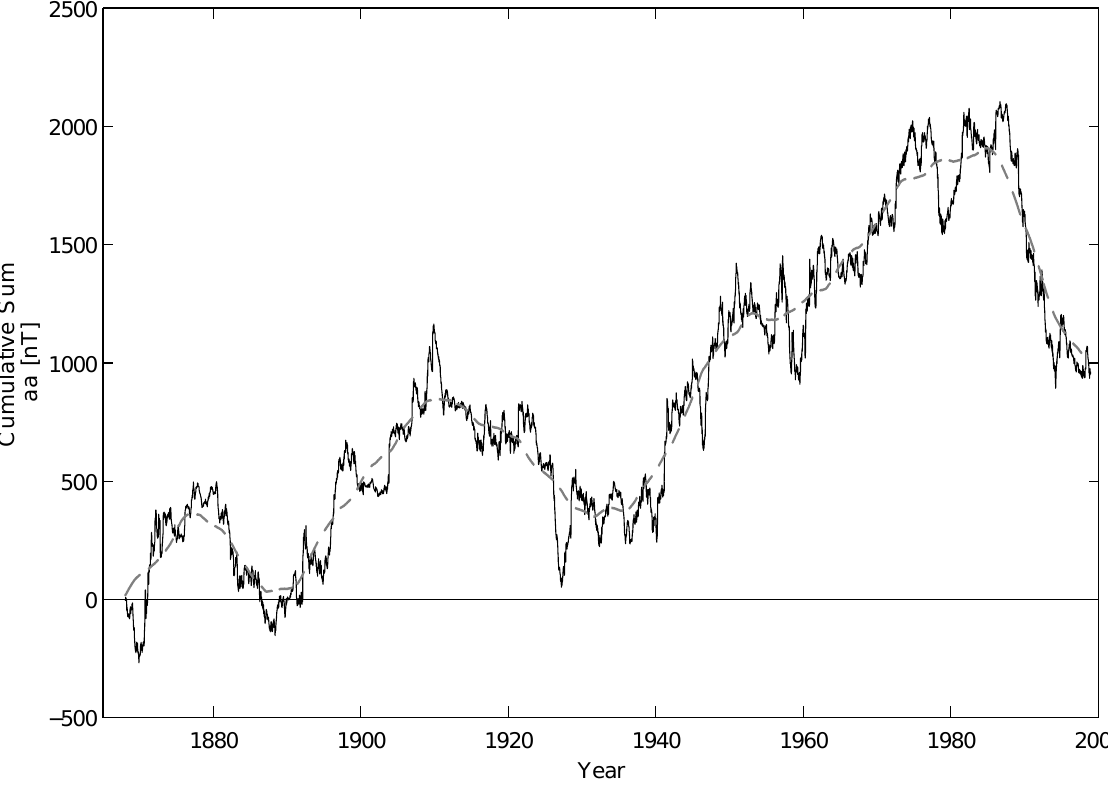
Fig. 3. Cumulative sum of weekend-weekday differences calculated from the aa indices (solid curve). Running 10-year mean is depicted as a dashed curve. Horizontal line depicts the zero level of cumulative